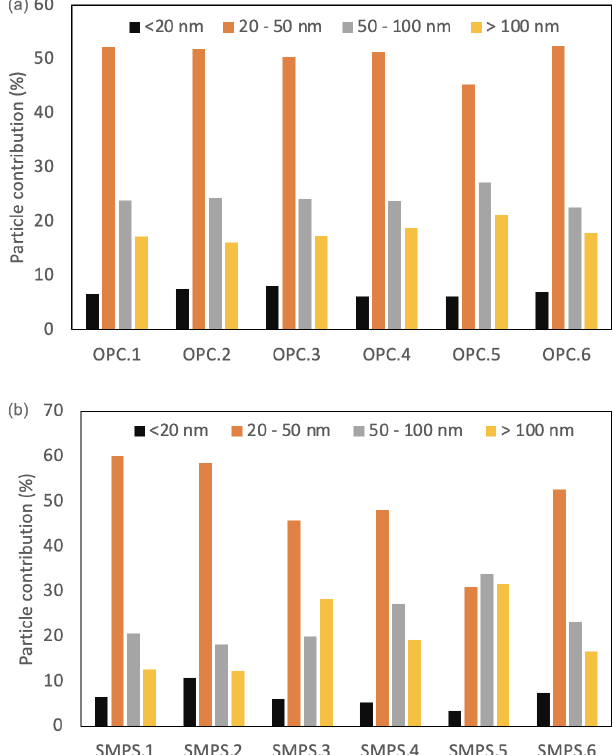
Figure 4. Particle contributions in the range 12–550nm (using the SMPS data) for the clusters formed using the OPC data (a) and the SMPS data (b)